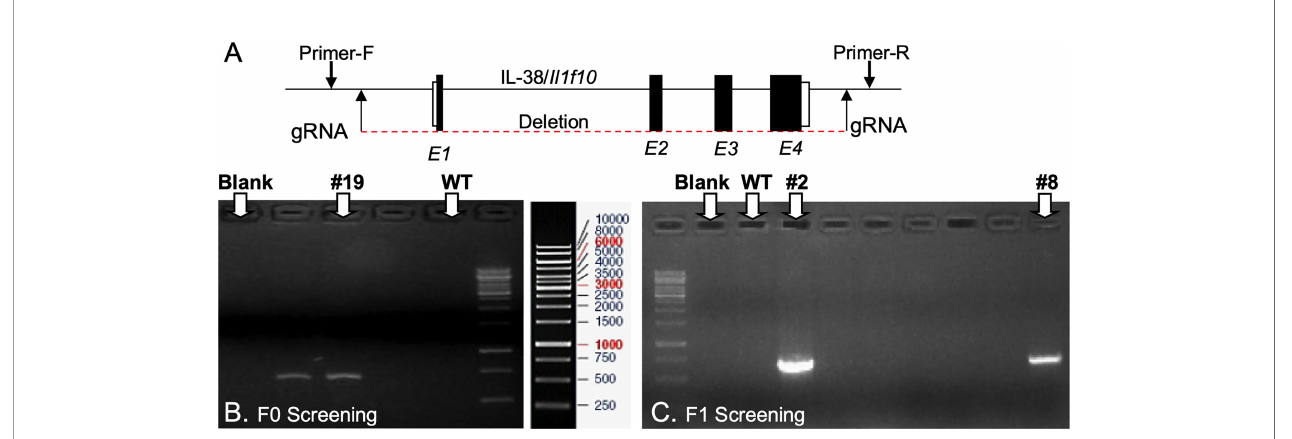
FIGURE 1 | Generation of IL-38/ Il1f10 de fi cient mice. (A) Representation of the IL-38 gene, exons are in black, gRNA and PCR primer locations are indicated with arrows. F0 (B) and F1 (C) Heterozygote Il1f10 de fi cient founder screening. PCR products were generated using primers in Table 1 and conditions listed in the Supplemental Material